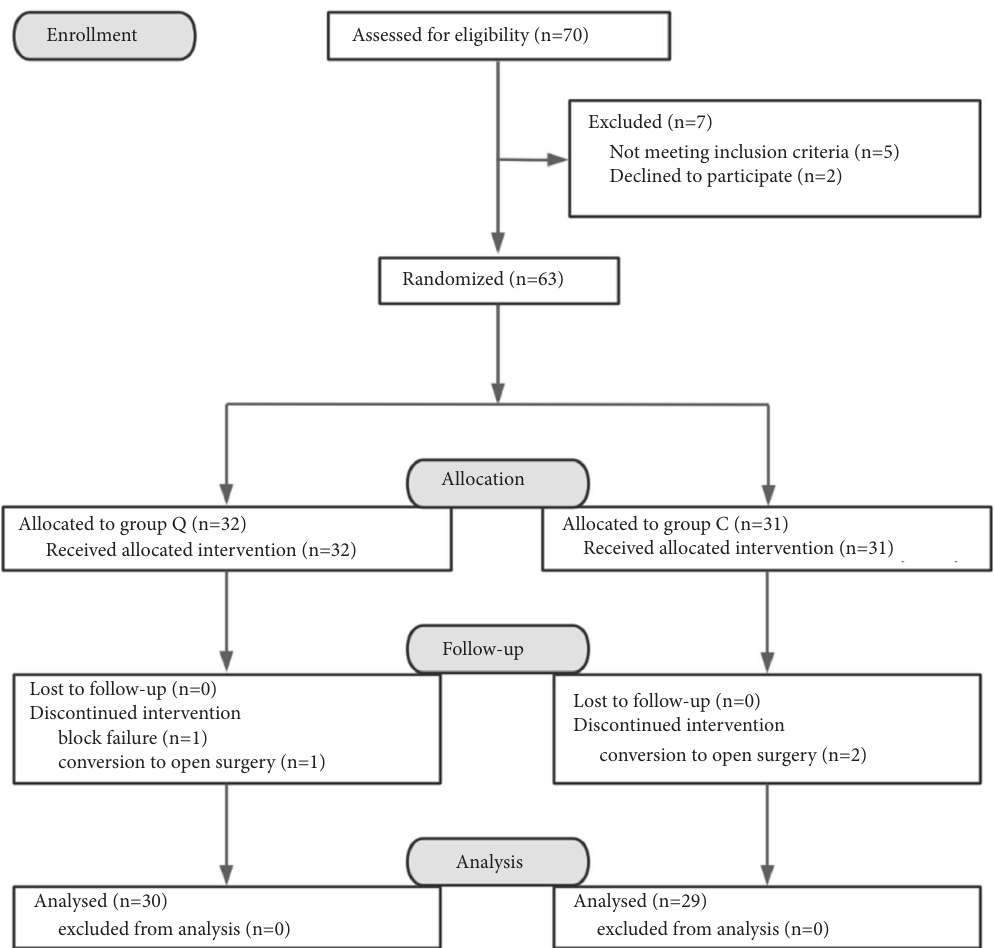
Figure 3: Consolidated standards of reporting trials (CONSORT)